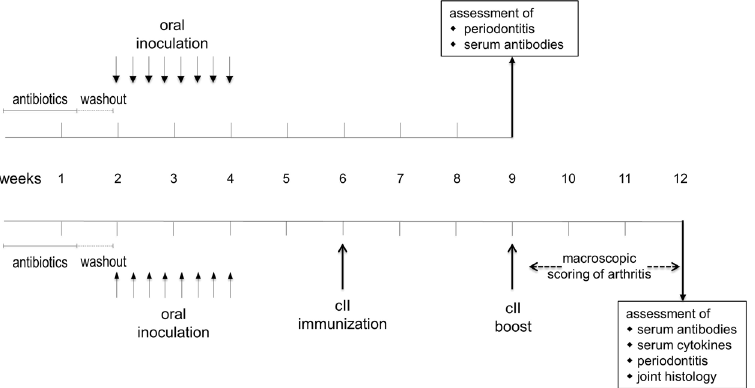
Figure 1. The experimental setup. For the induction of PD an initial antibiotic treatment followed by a washout period and eight oral inoculations with pathobionts was performed. In the absence of subsequent arthritis induction (upper diagram), mice were monitored for five weeks before they were sacrificed, serum assessed for antibodies and mandibles for alveolar bone loss. Arthritis induction (lower diagram) included a primary immunization with bovine collagen type II and a boost three weeks thereafter. Macroscopic signs of arthritis were monitored until the mice were sacrificed. Mandibles were assessed for alveolar bone loss, joints scored histologically and serum tested for inflammatory cytokines and